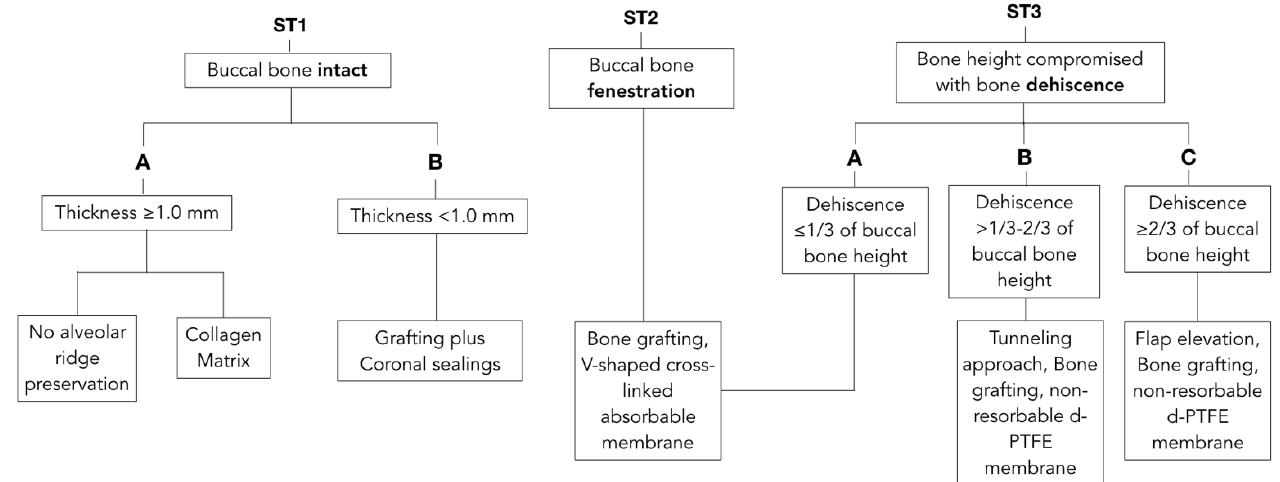
Figure 1 . Decision tree matching anatomical features with suggested treatment options. Unassisted healing and most documented techniques for alveolar ridge preservation have been related with the ST Classification. Each clinical scenario is correlated with the most suitable treatment approach to allow maximum regenerative potentials with the most conservative intervention.